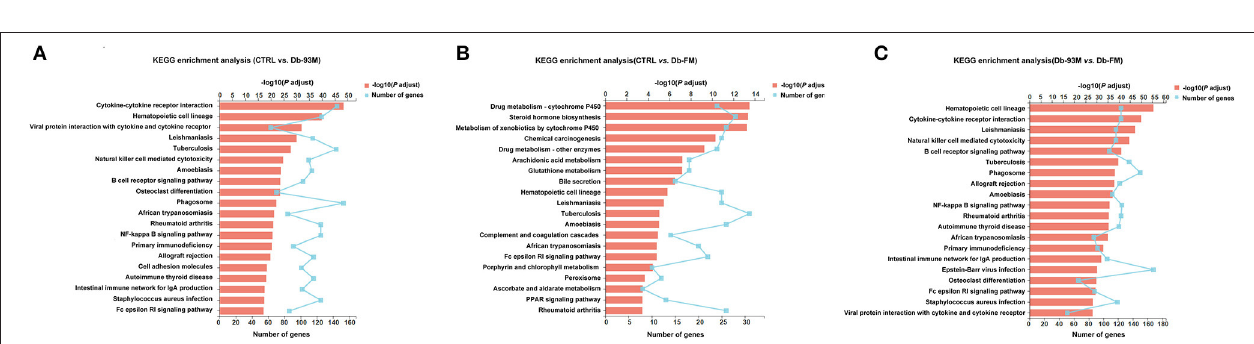
FIGURE 4 | The KEGG enrichment results (kidney tissues) based on the identified DEGs from. (A) Comparison of CTRL group and Db-93M group. (B) Comparison of CTRL group and Db-FM group. (C) Comparison of Db-93M group and Db-FM group.